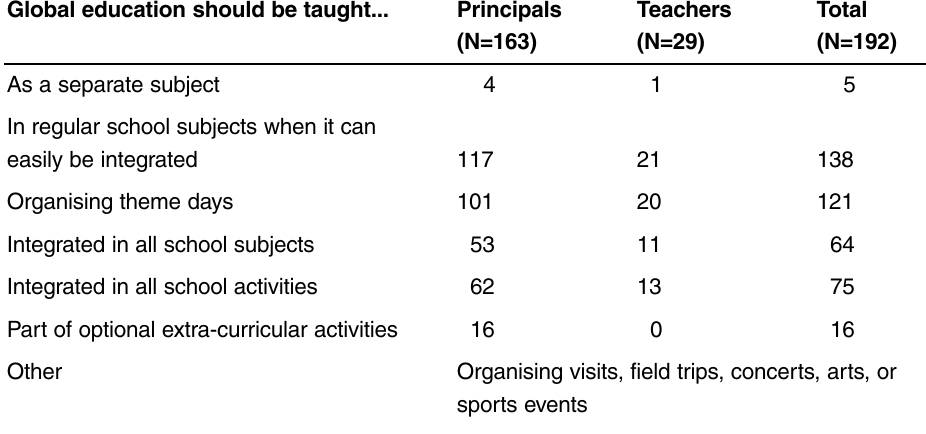
Table 2. Evaluation by Finnish basic education principals and teachers of the best practices for teaching global education, as defined in Global Education 2010 Programme in basic education institutions. Global education should be